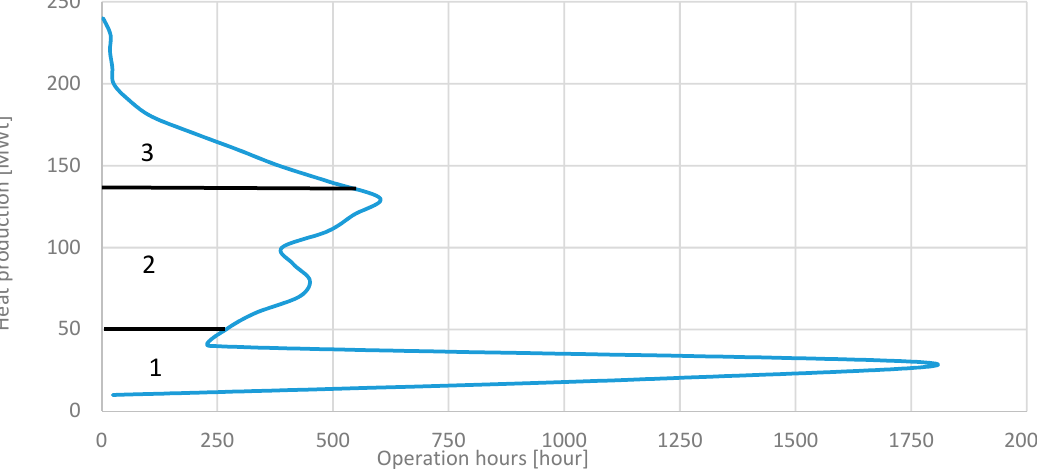
Figure 3. Limitation of the BPT at the produced heat power by the CPP in 2016 [5].